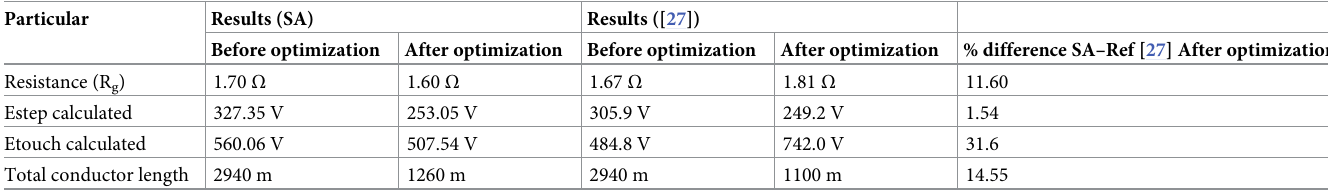
Table 15. Results for grounding system in horizontal two-layer soil ( ρ 1 > ρ 2 ).